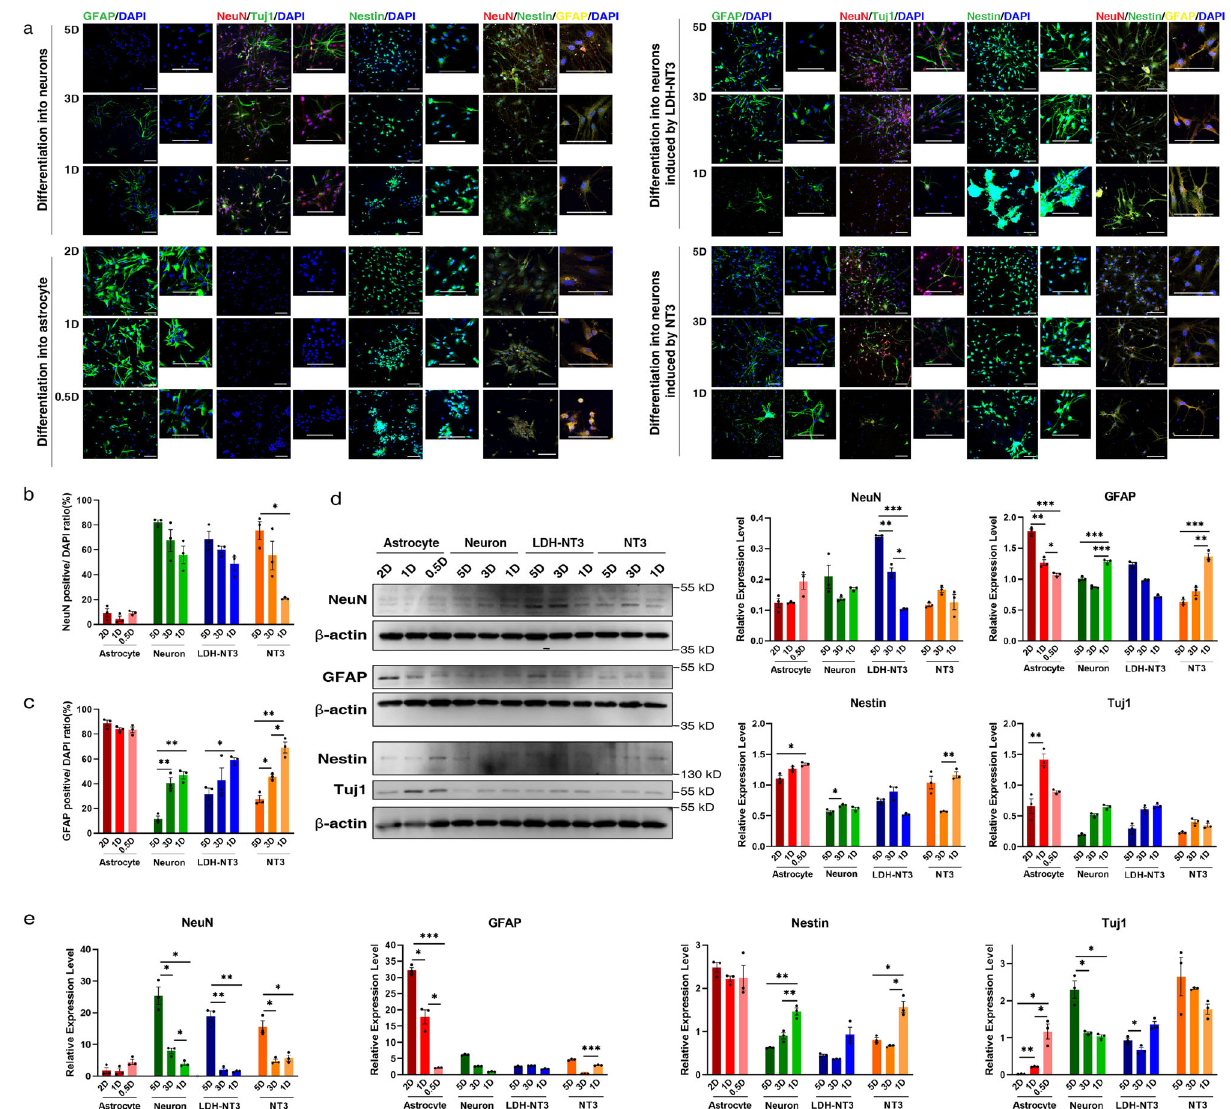
Fig. 2 Differentiation ef fi ciency of training and testing sets identi fi ed by immuno fl uorescence, western blot and RT-qPCR. a Images of immuno fl uorescent staining using NeuN, GFAP, Tuj1 and Nestin as characteristic markers of neuron and astrocyte differentiation induction at 5D (5 days), 3D (3 days), 2D (2 days), 1D (1 day) and 0.5D (0.5 days). Differentiated cells treated with NT3 and LDH-NT3 were stained following the same protocols. Quanti fi cation of immunostaining data. The y- axis shows the number of: b NeuN- and c GFAP-positive cells, n = 3 imaging fi eld repeats. d Western blot analysis of NeuN, GFAP, Nestin and Tuj1 protein in NSCs in different states of differentiation, n = 3 biological repeats. e Quantitative real-time PCR detection of NeuN, GFAP, Nestin and Tuj1 gene expression in cells in different states of differentiation, n = 3 biological repeats. Data are shown as mean ± SEM. Statistical signi fi cance was determined by two-sided Welch ’ s ANOVA. * p < 0.05, ** p < 0.01, *** p < 0.001. Scale bar = 100 μ m. LDH: layered double